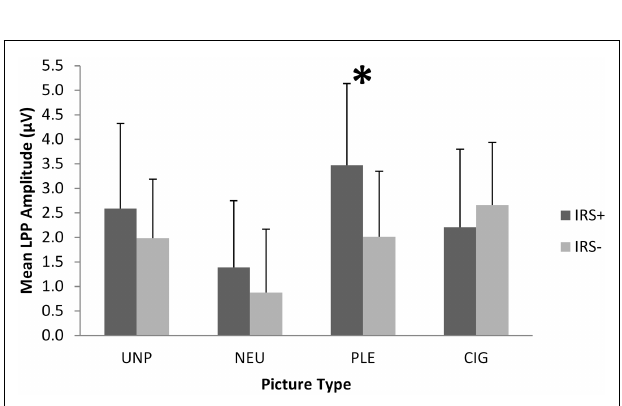
FIGURE 2 |The IRS group (IRS + vs. IRS − ) by picture category (UNP, NEU, PLE, CIG) interaction on mean LPP amplitude .The error bars depict standard deviations. *Significant pairwise comparison, p <